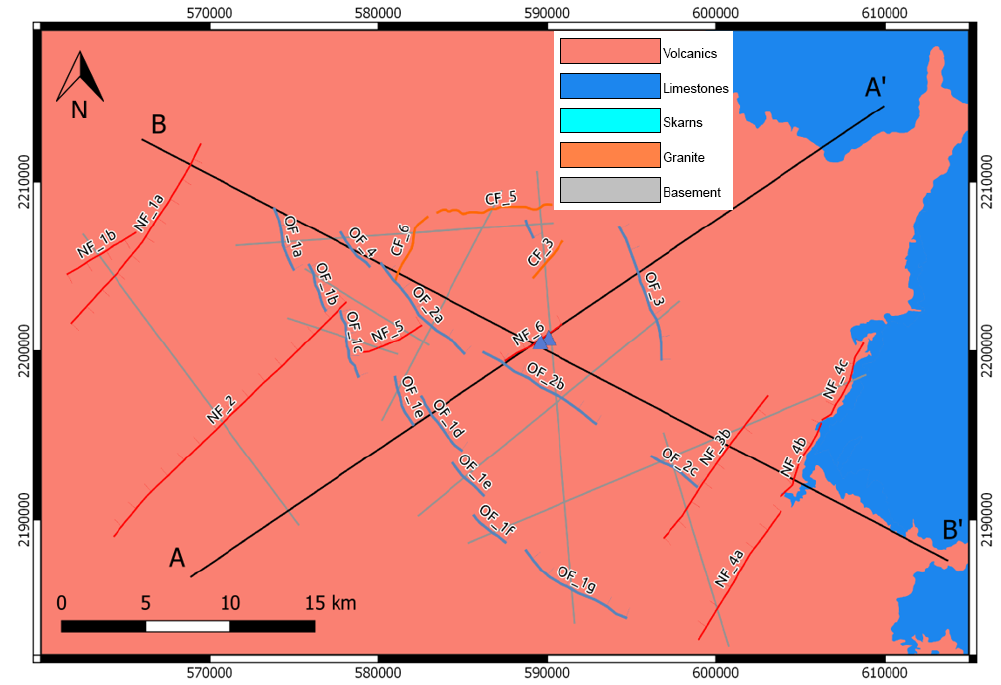
Figure 7. Acoculco geological map reinterpreted from Avellán et al. (2018a) using the five groups selected for the modelling. Blue triangles: location of the two wells used for modelling. Fault traces: normal faults (red), strike to oblique slip movement (blue), faults developed during the caldera collapse evolution (orange). AA’ and BB’: two main interpreted cross-sections (see Fig. 13). Dark grey trace: additional cross-section interpreted to constrain the model. Coordinate system is WGS84/UTM zone 14N.